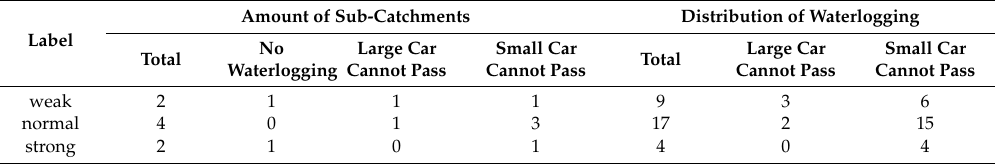
Table 8. The typical waterlogging points distribution inside Third Ring Road of Wuhan. As listed in the number of sub-catchments, there are eight sub-catchments inside Third Ring Road, and there are two sub-catchments that have no waterlogging points. The columns “Large car cannot pass” and “Small car cannot pass” indicate di ff erent depths of waterlogging points, where the depth in the former is higher than in the latter. The distribution of waterlogging section lists the quality of points in three classes of sub-catchment,